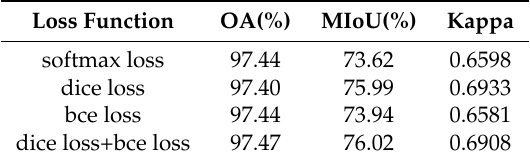
Table 3. Effect of different loss functions on road segmentation